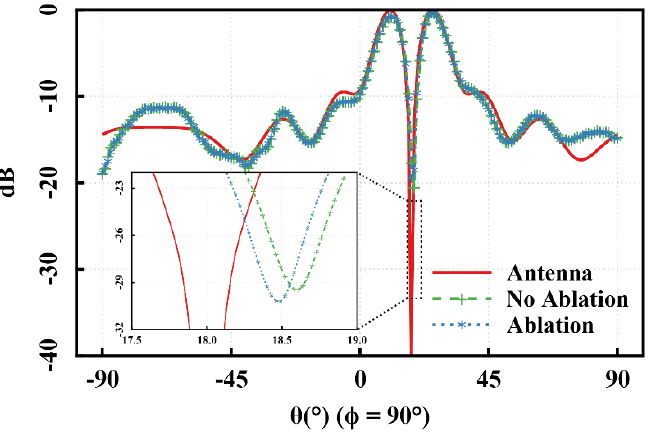
Figure 6. The overall difference patterns of ARS with and without ablation are compared when aiming angle θ = 18° and the local magnification graph near the valley of the pattern are also shown to make things clear.